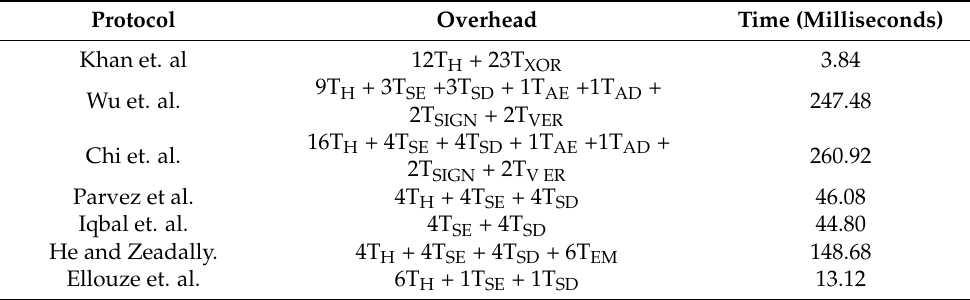
Table 7. Computational overheads of the authentication protocols.